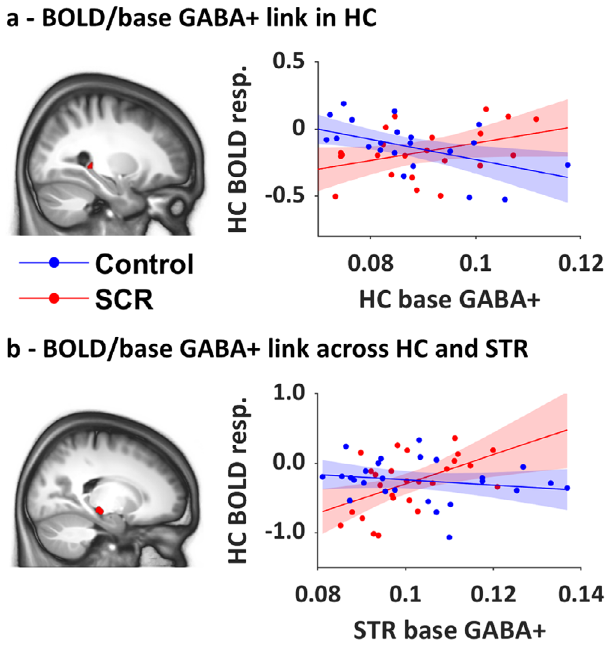
Fig. 6 Correlations between task-related BOLD responses during MSL and baseline GABA + measures. For display purposes, activation maps are overlaid on a T1-weighted template image with a threshold of p < 0.005 uncorrected. Regression plots represent BOLD responses (resp.) [practice > rest] against baseline GABA + measures for the two groups. a Link between BOLD and GABA + within the HC: right HC activation [28 − 36 0 mm] was differently correlated with HC baseline GABA + in the SCR and control groups. b Link between BOLD and GABA + across regions: left HC activation [ − 18 − 24 − 10mm] was differently correlated with STR baseline GABA + in the SCR and control groups. Due to missing fMRI data, one control participant was not included in the regressions with HC GABA + : N Control = 23, N SCR = 22. Regressions with STR GABA + : N Control = 26, N SCR = 26. BOLD and GABA measures are in arbitrary units.